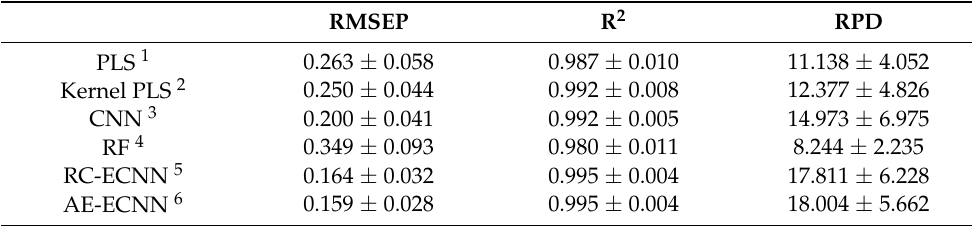
Table 3. Regression results of the melamine data set obtained by the AM-ECNN and the contrast methods.